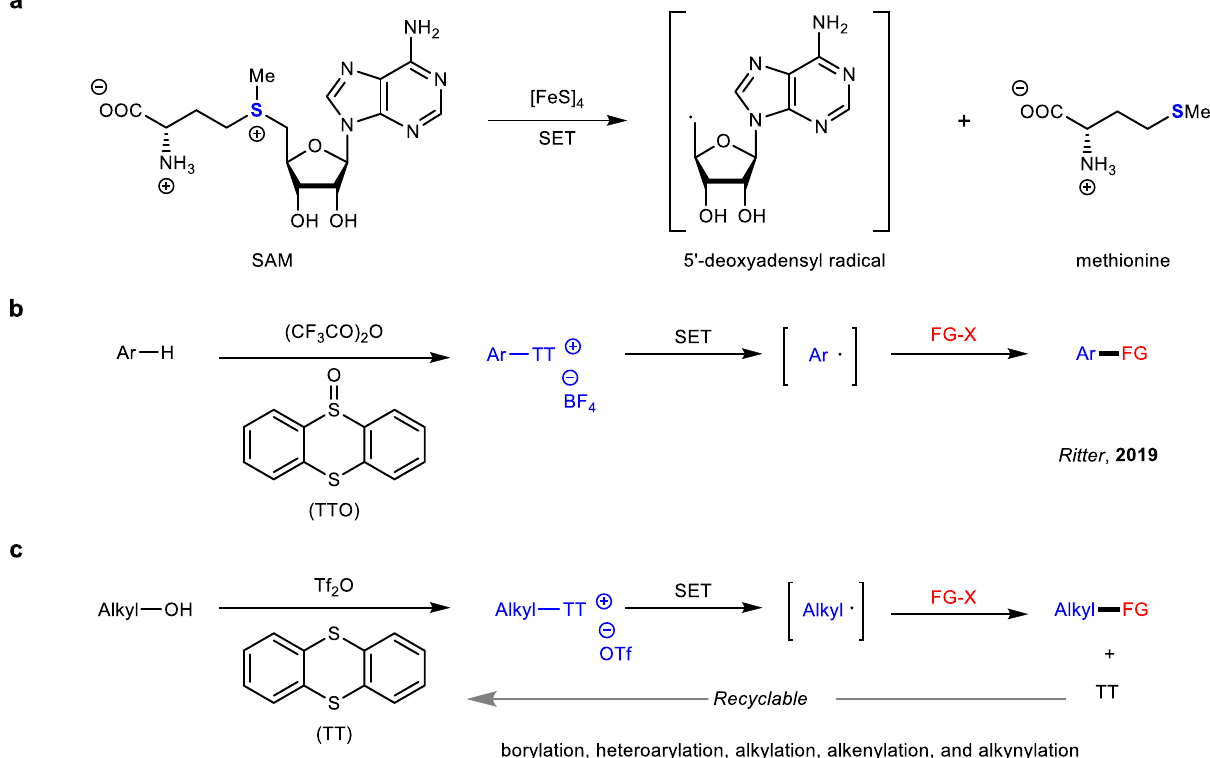
Fig. 1 Generation of radicals from sulfonium salts. a Radical SAM cleavage in biosynthesis. b Generation of aryl radicals from S -(aryl) thianthrenium salts. c Generation of non-stabilized alkyl radicals from S -(alkyl) thianthrenium